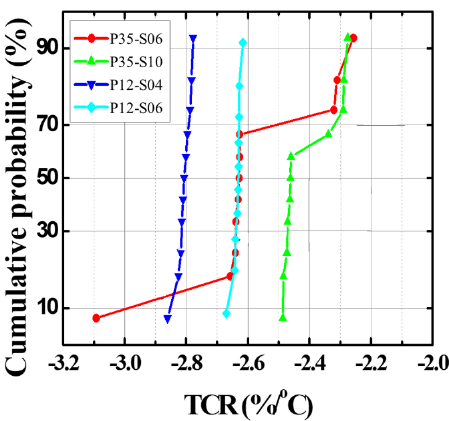
Figure 5. The resistance variations as a function of temperature for the four types of a-Si microbolometers: ( a ) P35-S06, ( b ) P35-S10, ( c ) P12-S04, and ( d ) P12-S06. Here, DIE 1 to DIE 11 represent the microbolometers with the same structure fabricated in different locations on the substrate, and the S-TiN stands for the pattern spacing of TiN layer.